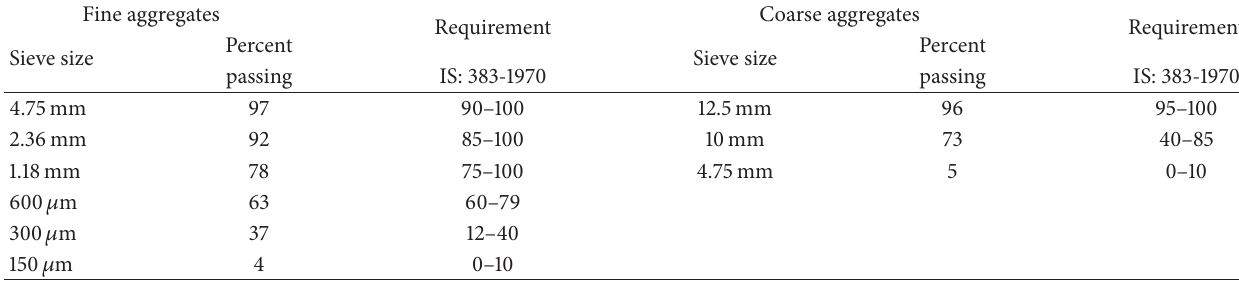
Table 2: Sieve analysis of aggregates.